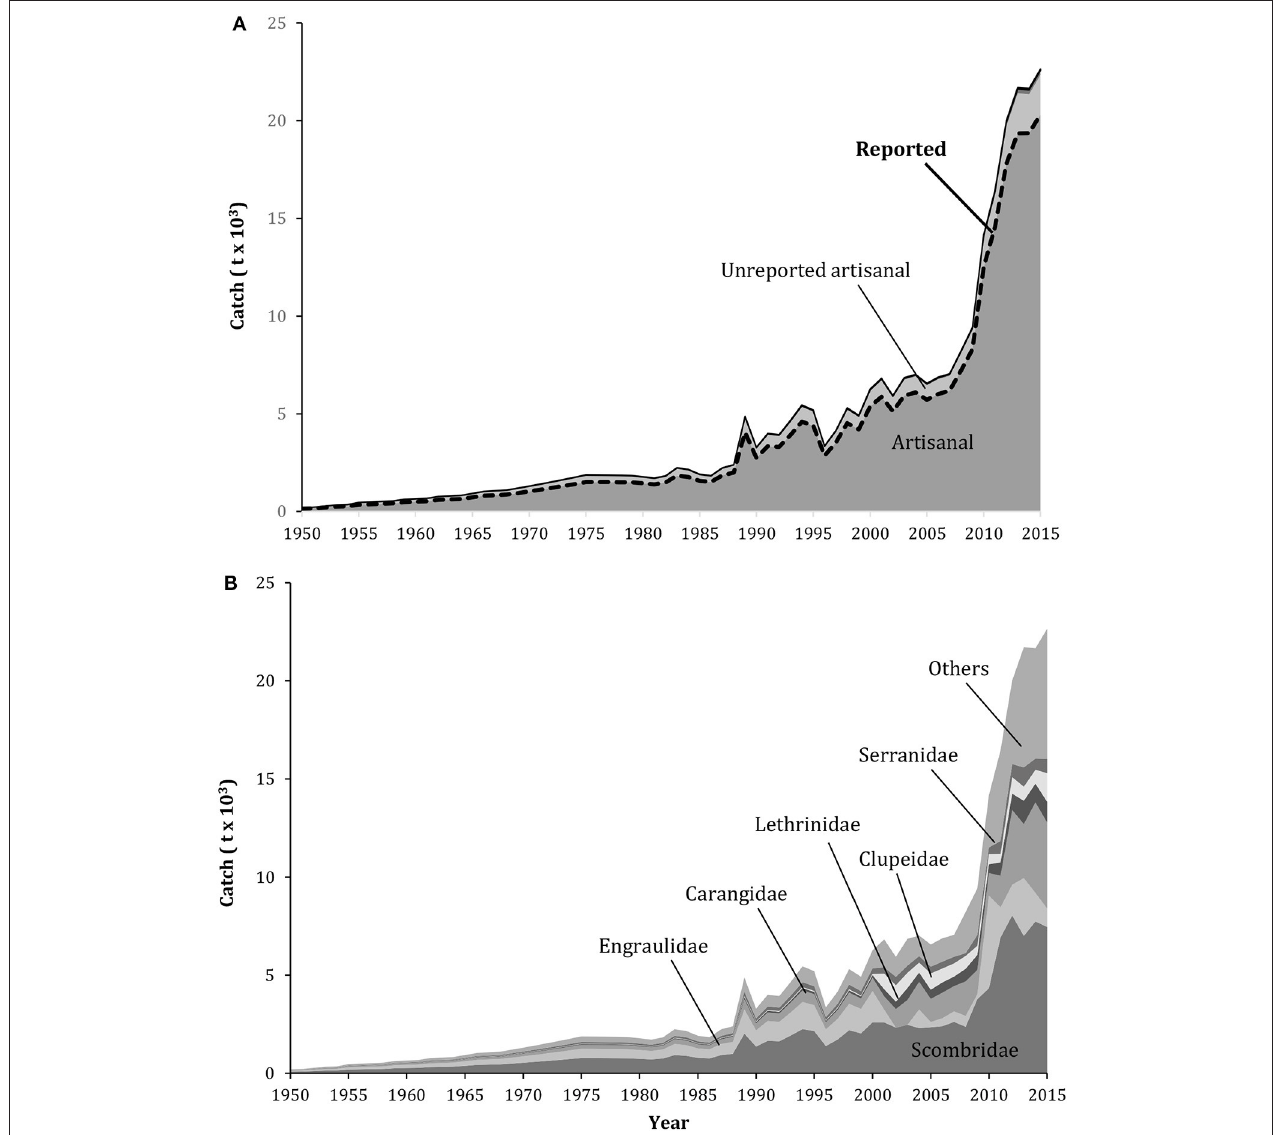
FIGURE 3 | Reconstructed catches for the Musandam Peninsula (Oman), 1950-2015, by (A) sectors shown separately and reported landings overlaid as a dashed line graph. Discards, subsistence and recreational catches are included, but are too small to be visible; and (B) by main taxonomic group. “Others” includes 17 additional taxonomic